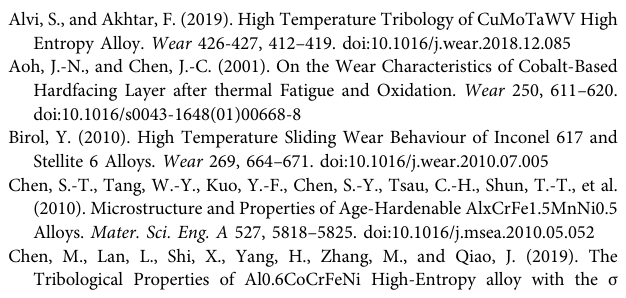
Frontiers in Materials |